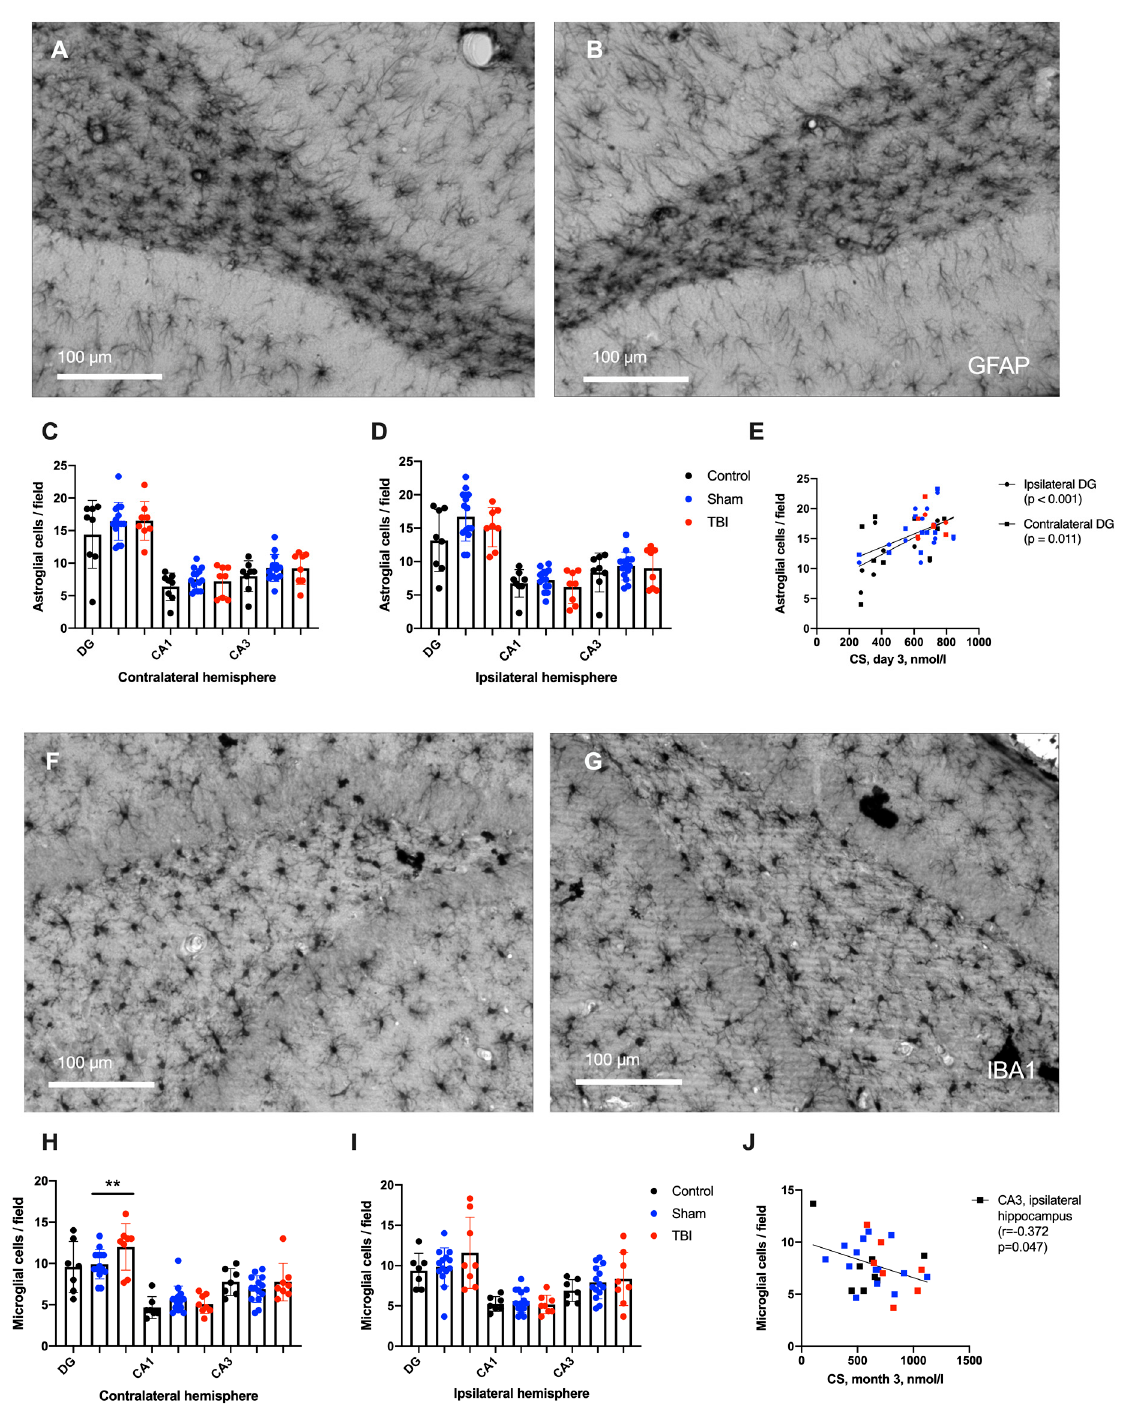
Figure 5. Gliosis in the hippocampus 3 months after TBI. ( A , B )—Astroglial cells in contralateral and ipsilateral hippocampal DGs, respectively; anti-GFAP staining. ( C , D )—Astroglial cell density in the contralateral and ipsilateral hemispheres, respectively. ( E )—Correlation between astroglial cell density and acute CS levels on day 3 after TBI (Spearman correlation). ( F , G )—Microglial cells in the contralateral and ipsilateral hippocampal DGs, respectively; anti-IBA1 staining. ( H , I )—Microglial cell density in the contralateral and ipsilateral hemispheres, respectively. Microglial activation was detected only in contralateral DGs. ( J )—Negative correlation between microglial cell density in CA3 and CS level 3 months after TBI (Spearman correlation). **— p < 0.01, Kruskal–Wallis test with post-hoc Dwass–Steel–Critchlow–Fligner